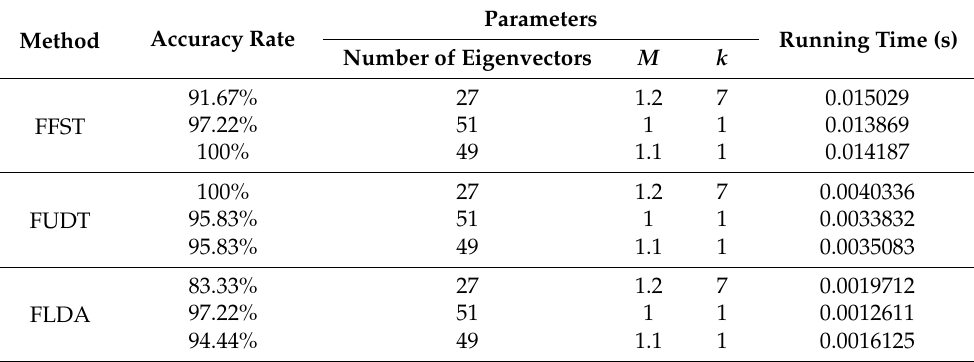
Table 1. The accuracy rates, parameters, and running time using FFST, FUDT, and FLDA.